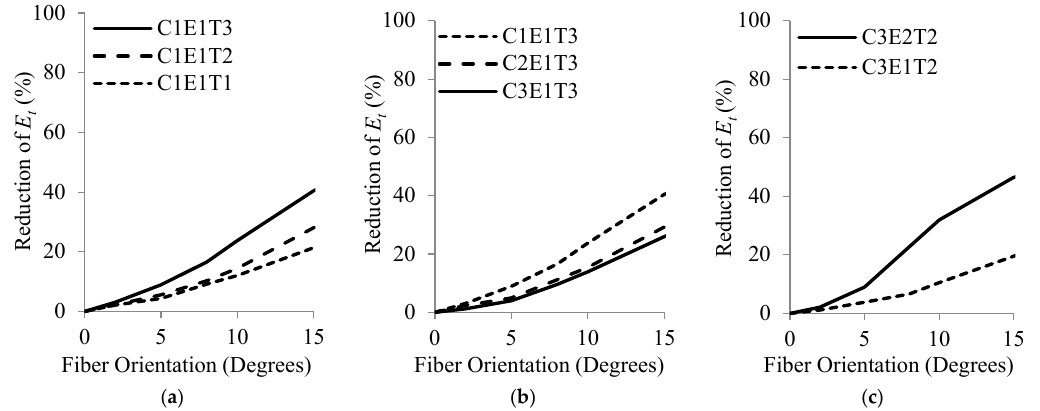
Figure 10. Variations of E t versus fiber orientation for selected specimens: ( a ) for t frp from 0.2 to 1.0 mm, ( b ) for f (cid:48) co from 20 to 50 MPa and ( c ) for E frp of 50 and 200 GPa. Table 11. Reduction in ε (cid:48) cu / ε (cid:48) co and E t due to deviation in fiber orientation for different values of E frp , t frp and f (cid:48) co .